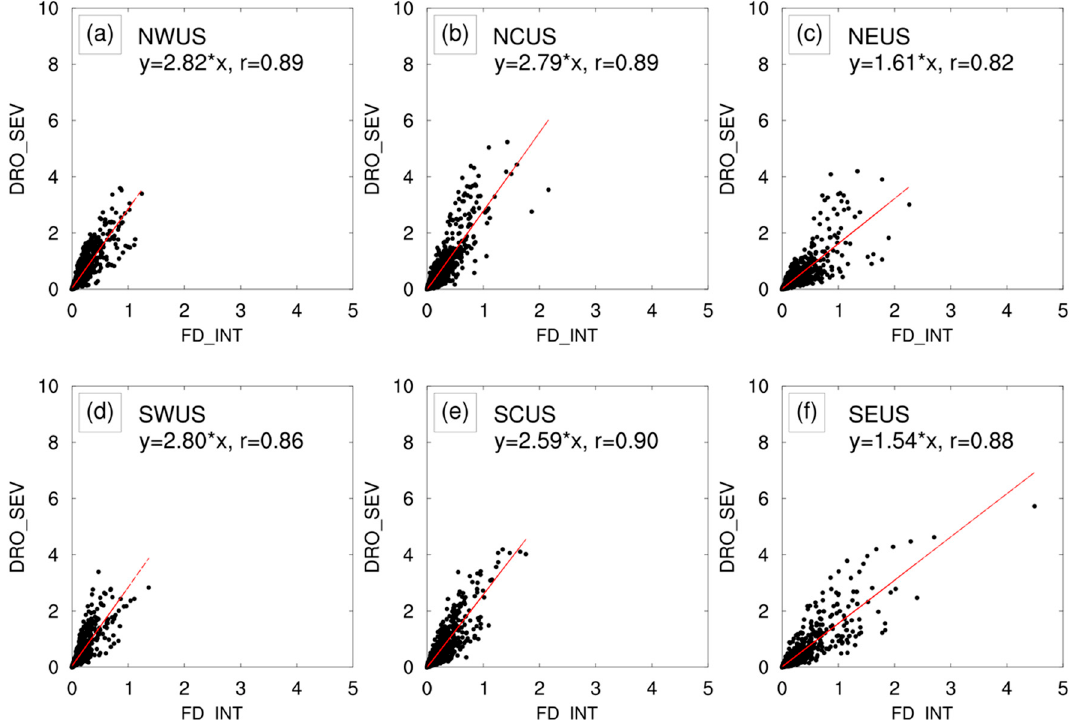
Figure 4. Scatterplot showing the relationship between the FD_INT and DRO_SEV terms for the ( a ) northwestern US, ( b ) north-central US, ( c ) northeastern US, ( d ) southwestern US, ( e ) south-central US, and ( f ) southeastern US regions shown in Figure 3a. The points represent spatial averages computed using data from each pentad for which flash drought occurred somewhere within a given region during April–October from 1979–2017. The red lines show the linear least squares fit for each region, with the slope of the regression and the Pearson correlation coefficient shown at the top of each panel.